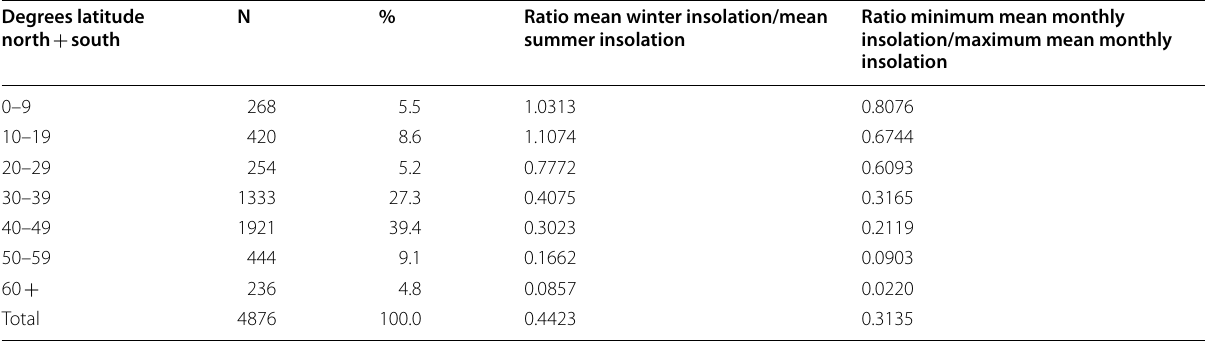
Table 2 Ratio of mean winter solar insolation/mean summer solar insolation and ratio of minimum mean monthly insolation/ maximum mean monthly insolation by latitude for patient onset locations (N 4876) = Degrees latitude N % Ratio mean winter insolation/mean Ratio minimum mean monthly north south summer insolation insolation/maximum mean +